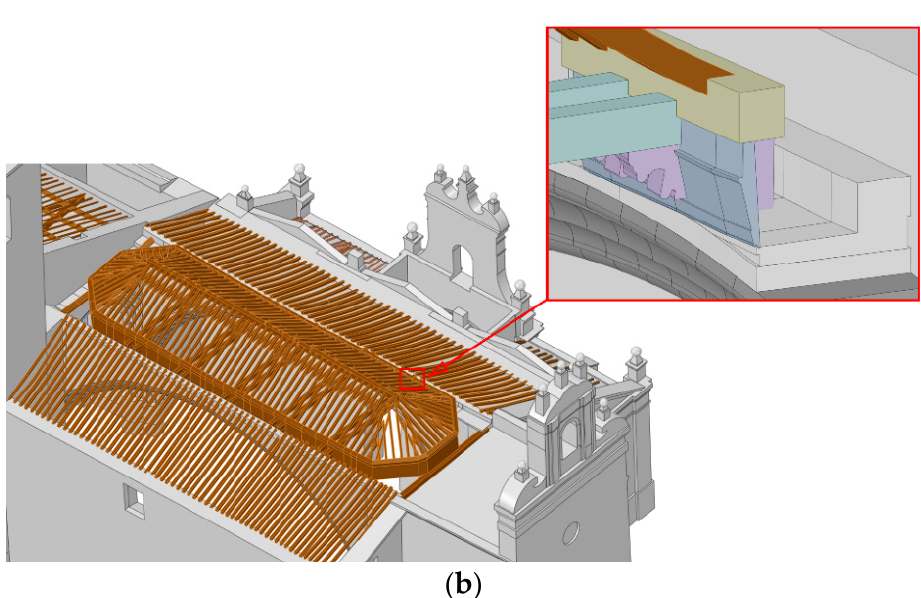
Figure 10. General views of the timber structure modelled in this work: ( a ) the timber elements on the transept and ( b ) the timber structure at the central nave on which it is possible to observe the high level of detail, considering all the structural elements as well as its joints.